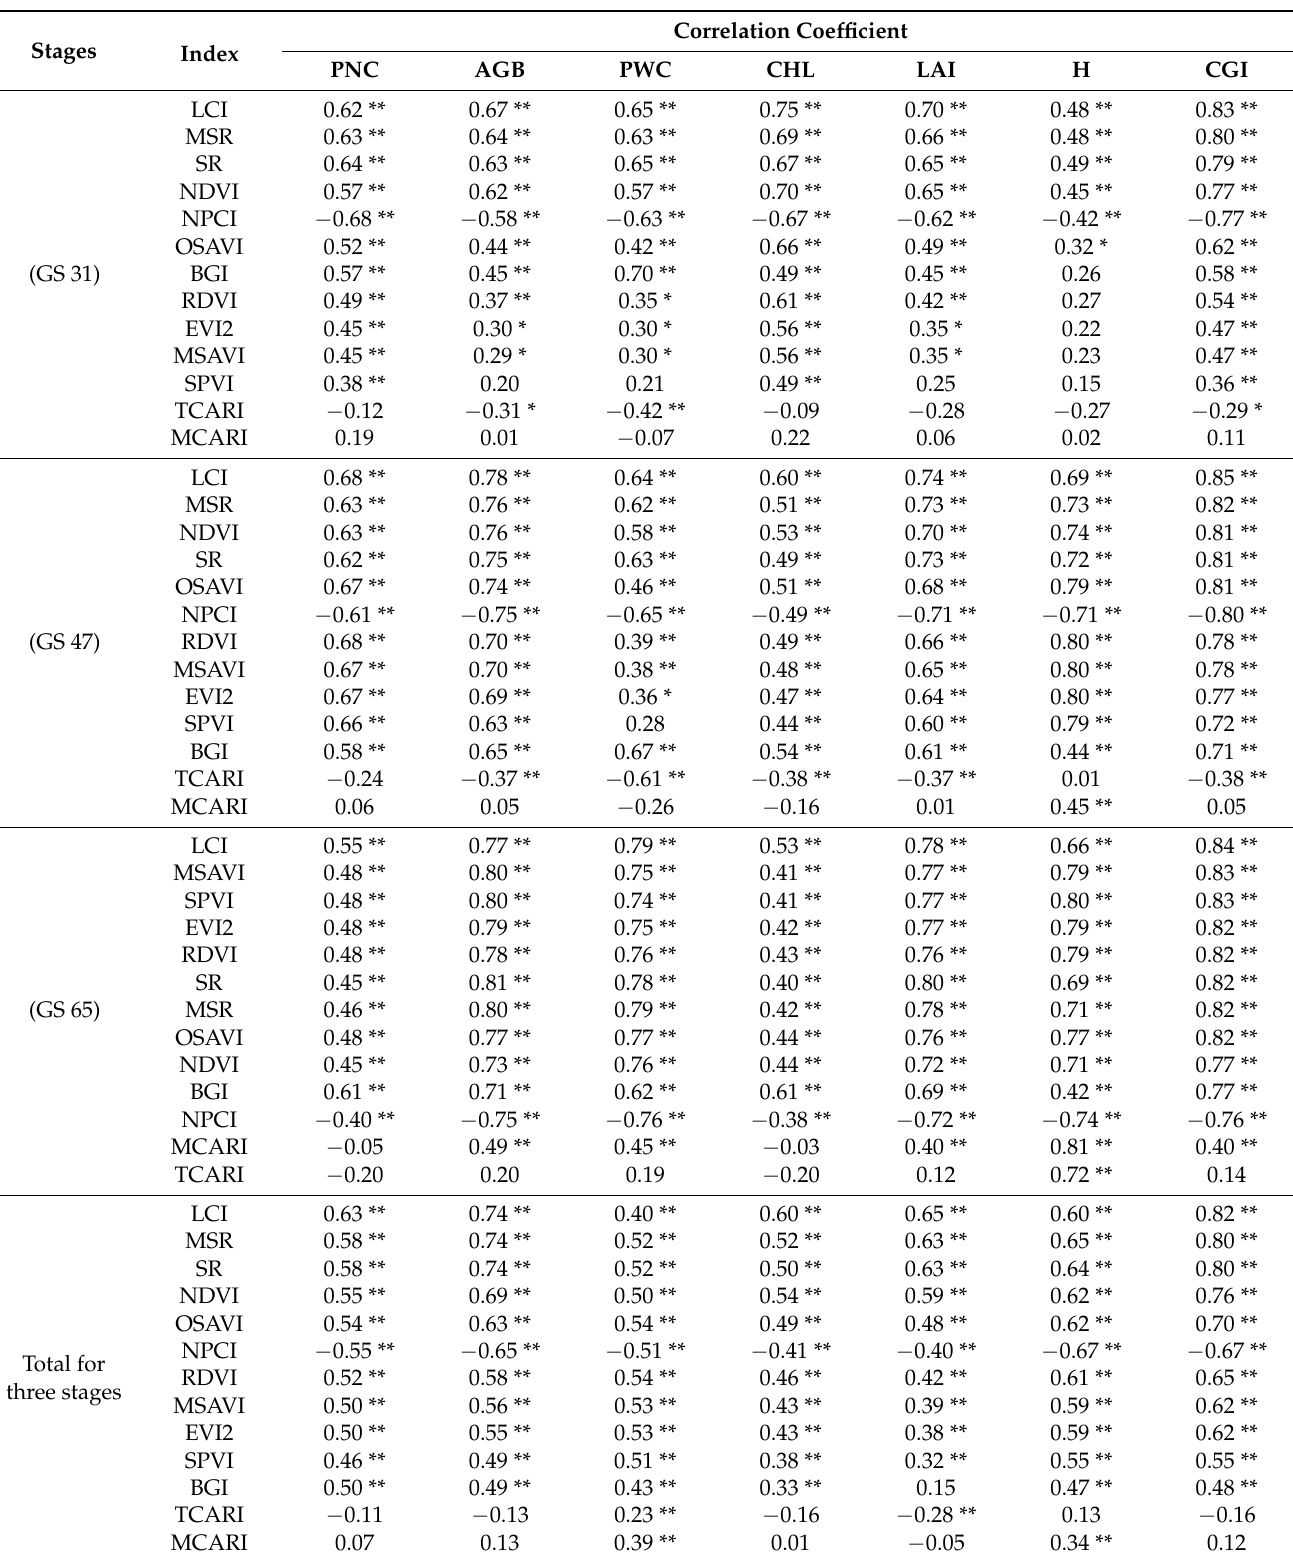
Table 3. Results of correlation analysis between the spectral indices, single indicator, and the